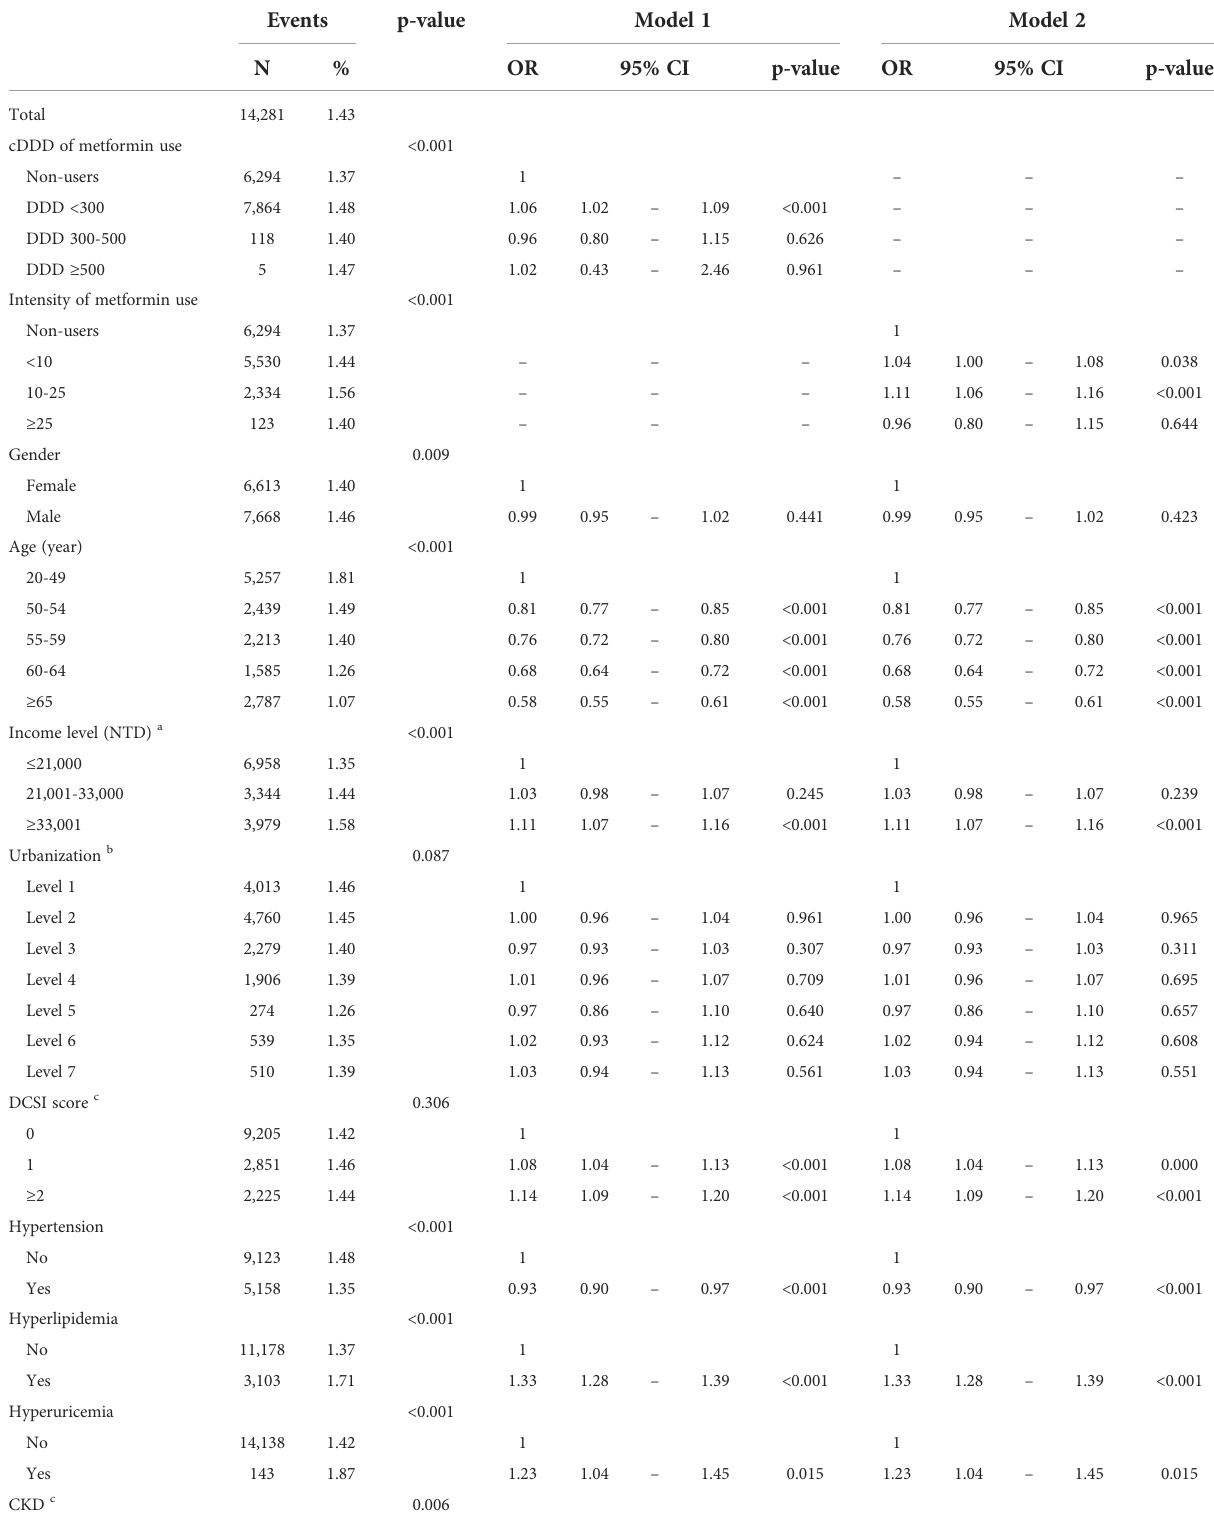
TABLE 3 Five-year follow-up of incident non-alcoholic fatty liver disease in new-onset diabetes mellitus patients with metformin